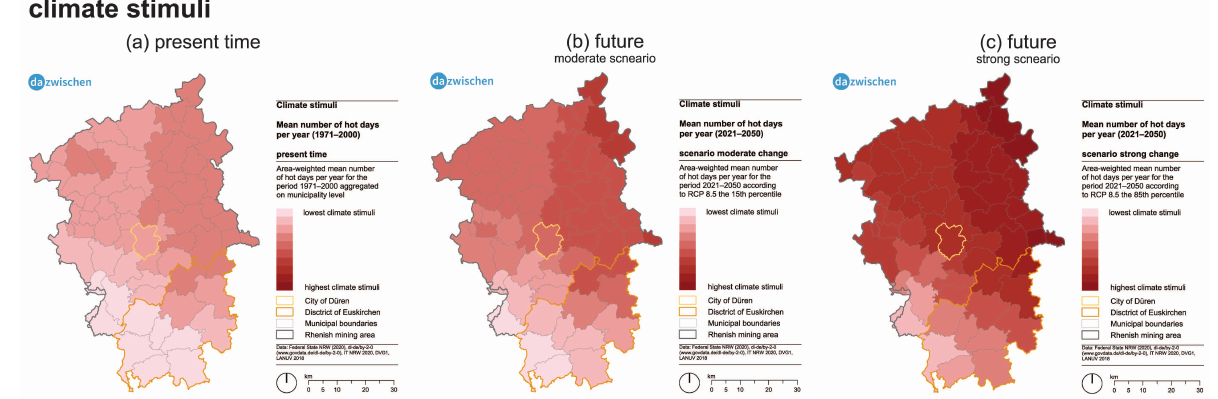
Figure 3. Results for the climate stimuli of the indicator “Heat stress of population”: ( a ) Indicator expression for the present time ( b ) Indicator expression for the future under a moderate scenario ( c ) Indicator expression for the future under a strong